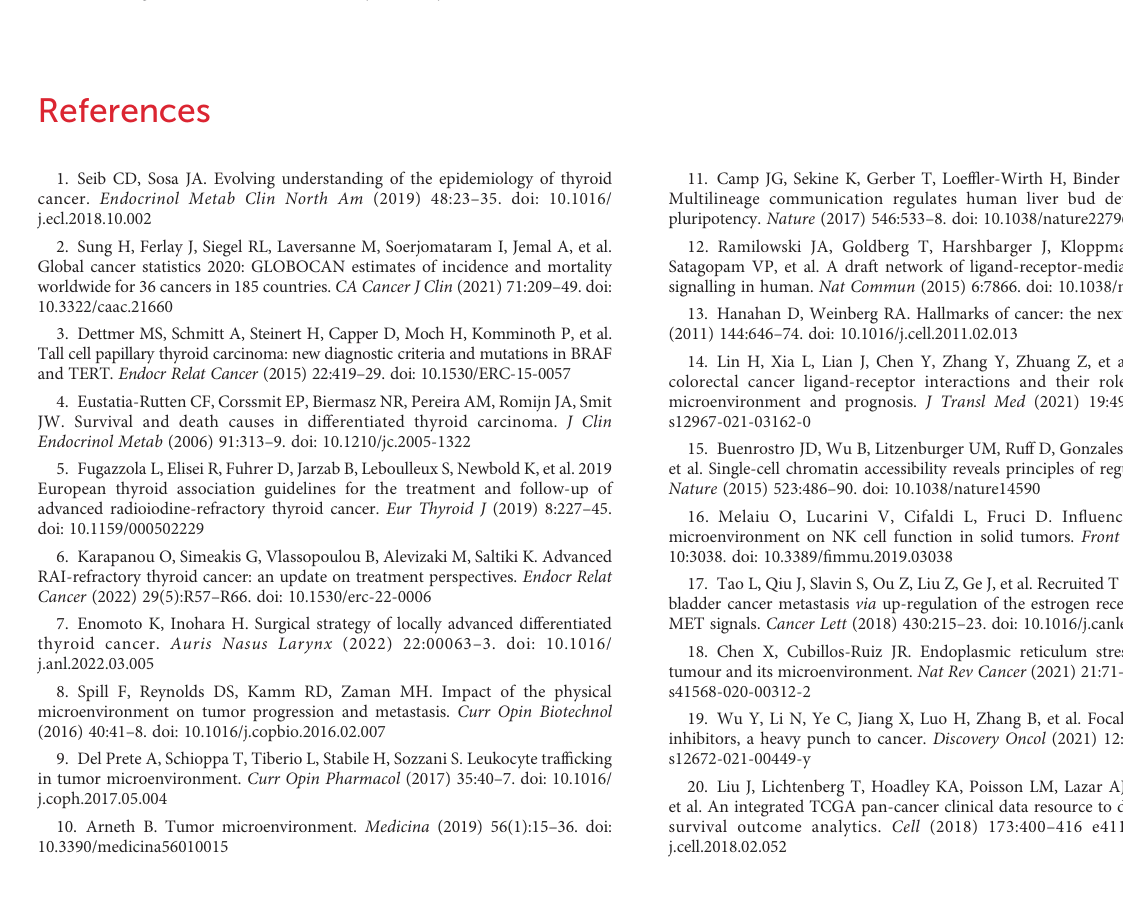
SUPPLEMENTARY TABLE 1 Differential analysis of 16 L/R pairs in detail. SUPPLEMENTARY TABLE 2 Univariate Cox regression analysis of 16 L/R pairs. SUPPLEMENTARY TABLE 3 Differential genes associated with CADM1-CADM in TCGA. SUPPLEMENTARY TABLE 4 279 positively correlated genes and 2 negatively correlated genes. SUPPLEMENTARY TABLE 5 The results of KEGG and GO enrichment analysis. SUPPLEMENTARY TABLE 6 The distribution of